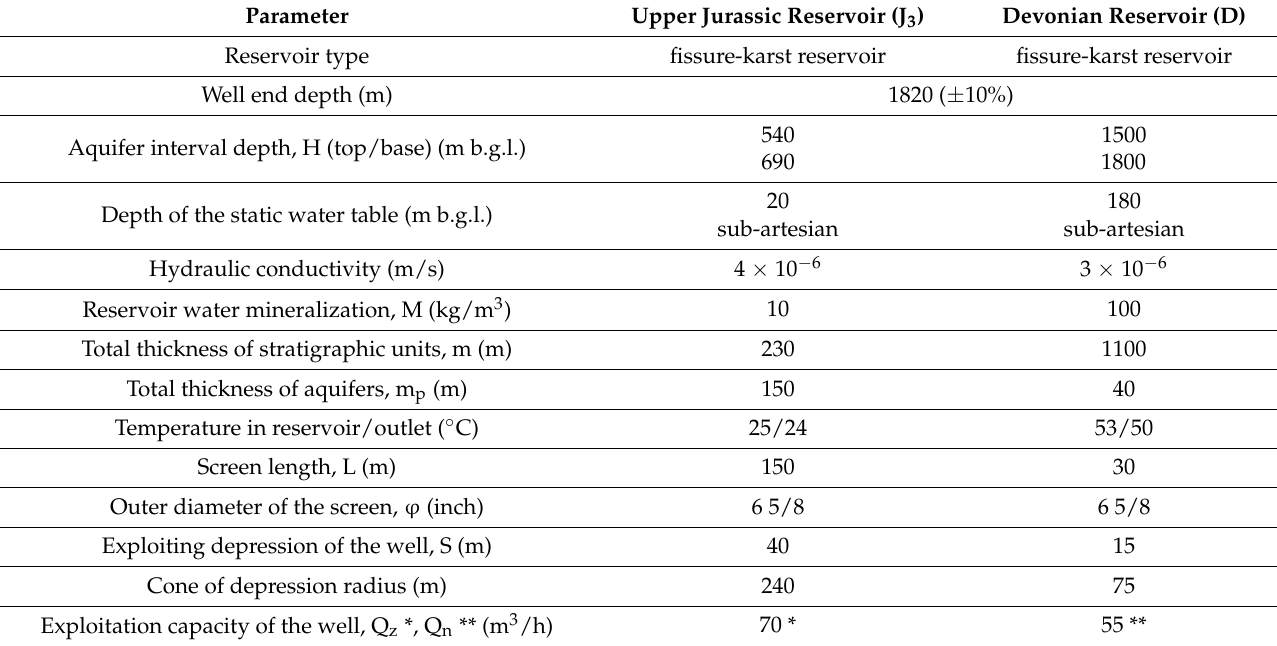
Table 1. Predicted parameters of geothermal water intakes in the south-eastern part of Krakow (adapted with permission from ref. [23] Copyright 2021 J. Kotyza, modified by M. Hajto).